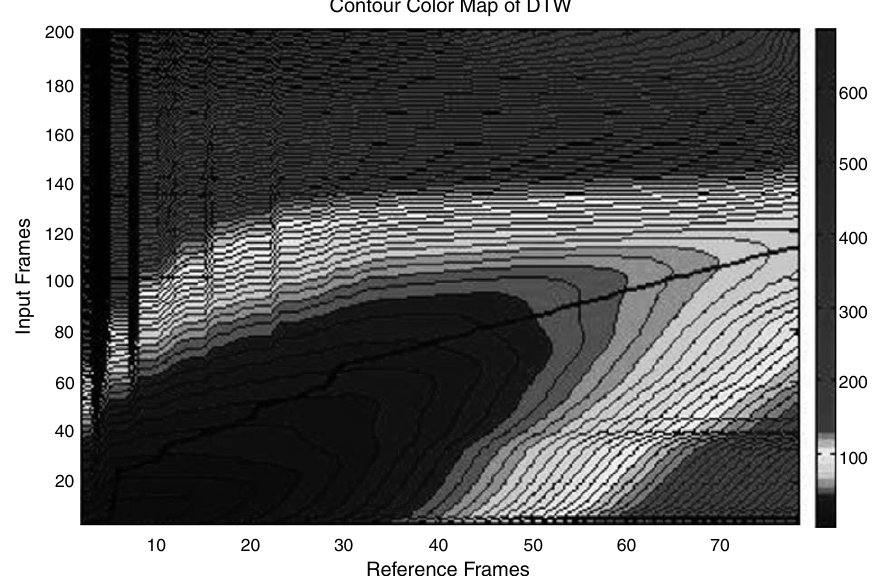
Fig. 4. Contour color map of DTW illustrating the optimal path for mapping an input sequence to a reference sequence for one articipant with a separate input sequence provided by the same